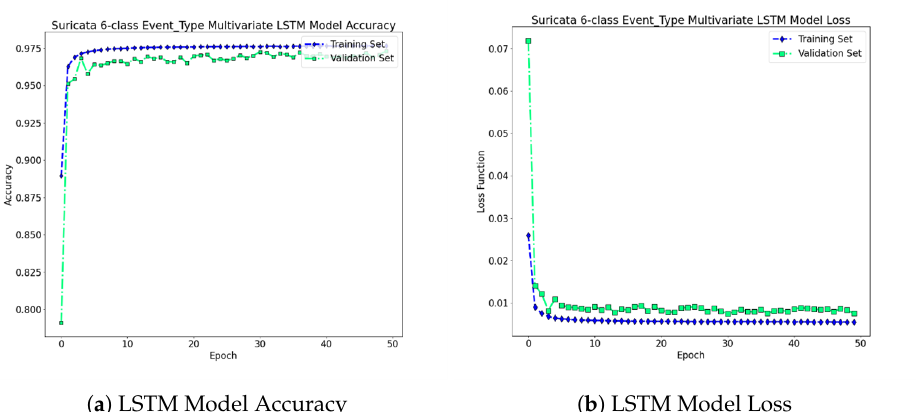
Figure 7. Multiclass LSTM Classification Accuracy and Model Loss Functions: We observe that both the classification accuracy and the loss functions during training/testing phase depict proper convergence rates after a small number of epochs, i.e., approximately after the 10th epoch, validating the robustness of the proposed LSTM